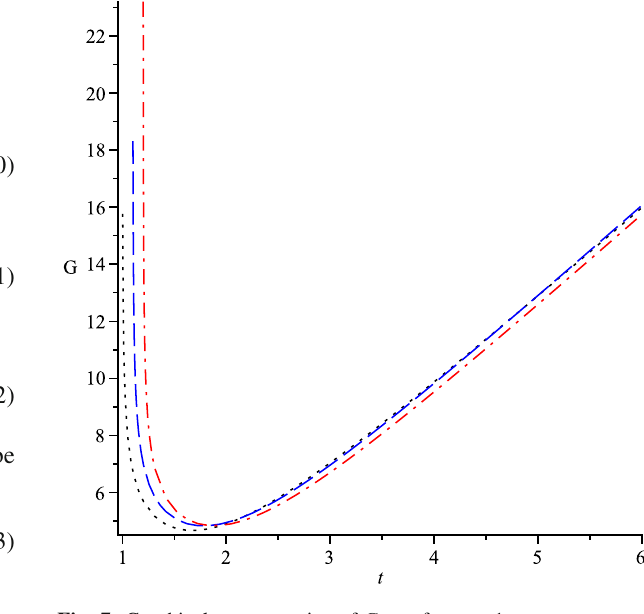
Fig. 7 Graphical representation of G vs t for γ = 1